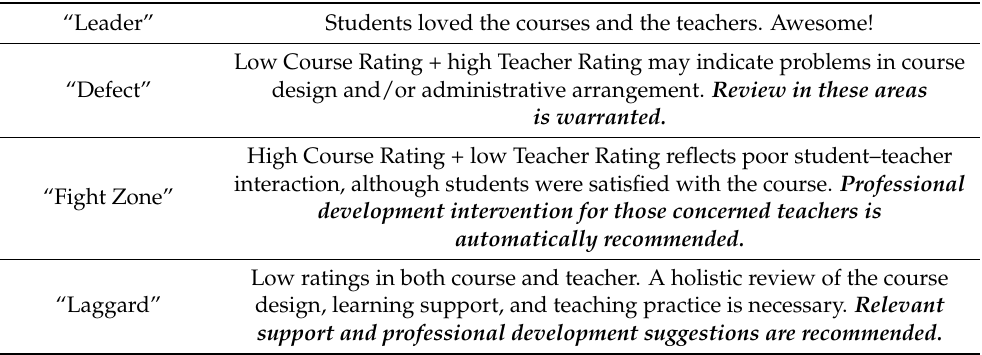
Table 3. The definition of Course–Teacher Rating Matrix. “Leader” “Defect” design and/or administrative arrangement. Review in these